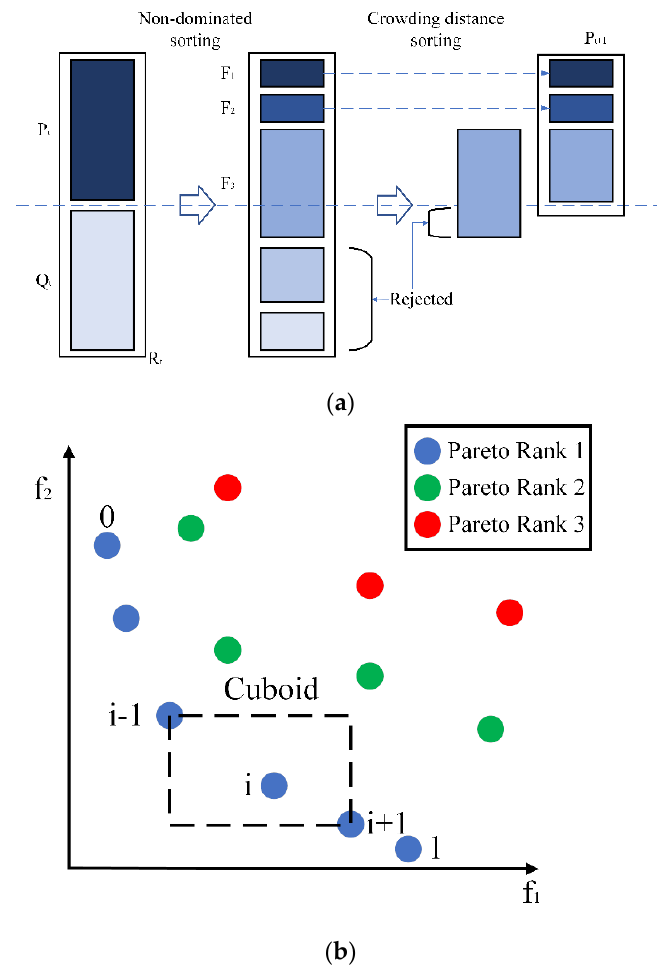
Figure 10. ( a ) Fast non-dominated sort; ( b ) elitist selection.